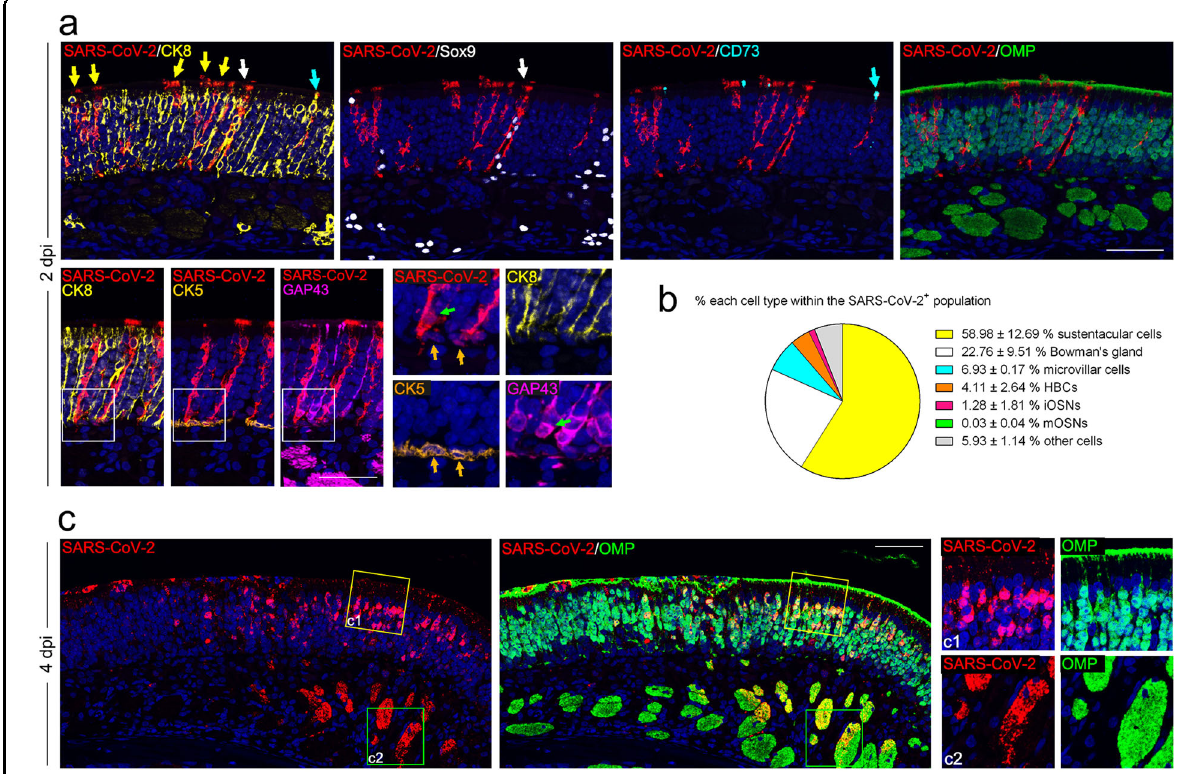
Fig. 2 SARS-CoV-2 primarily targets non-neuroepithelial cells in the OE. a Representative multiplex immuno fl uorescent staining assay showing that SARS-CoV-2 (SARS-CoV-2 N protein positive) infects sustentacular cells (CK8 positive, yellow arrows), Bowman ’ s gland cells (Sox9/CK8 positive, white arrows), microvillar cells (CD73/CK8 positive, cyan arrows), HBCs (CK5 positive, gold arrows), and iOSNs (GAP43 positive, green arrows) at 2 dpi. Little SARS-CoV-2 N protein was detected within OMP-positive mOSNs. b Statistical analysis of the percentage of each cell compartment within SARS- CoV-2-positive cells. The data are presented as means ± SD ( n = 3). c Multiplex immuno fl uorescent staining results showing an OM sample at 4 dpi with SARS-CoV-2 detected in the OMP-positive mOSNs and the underlying nerve bundles. The framed areas labeled c 1 and c 2 are shown adjacently at larger magni fi cations. Scale bar, 50 μ